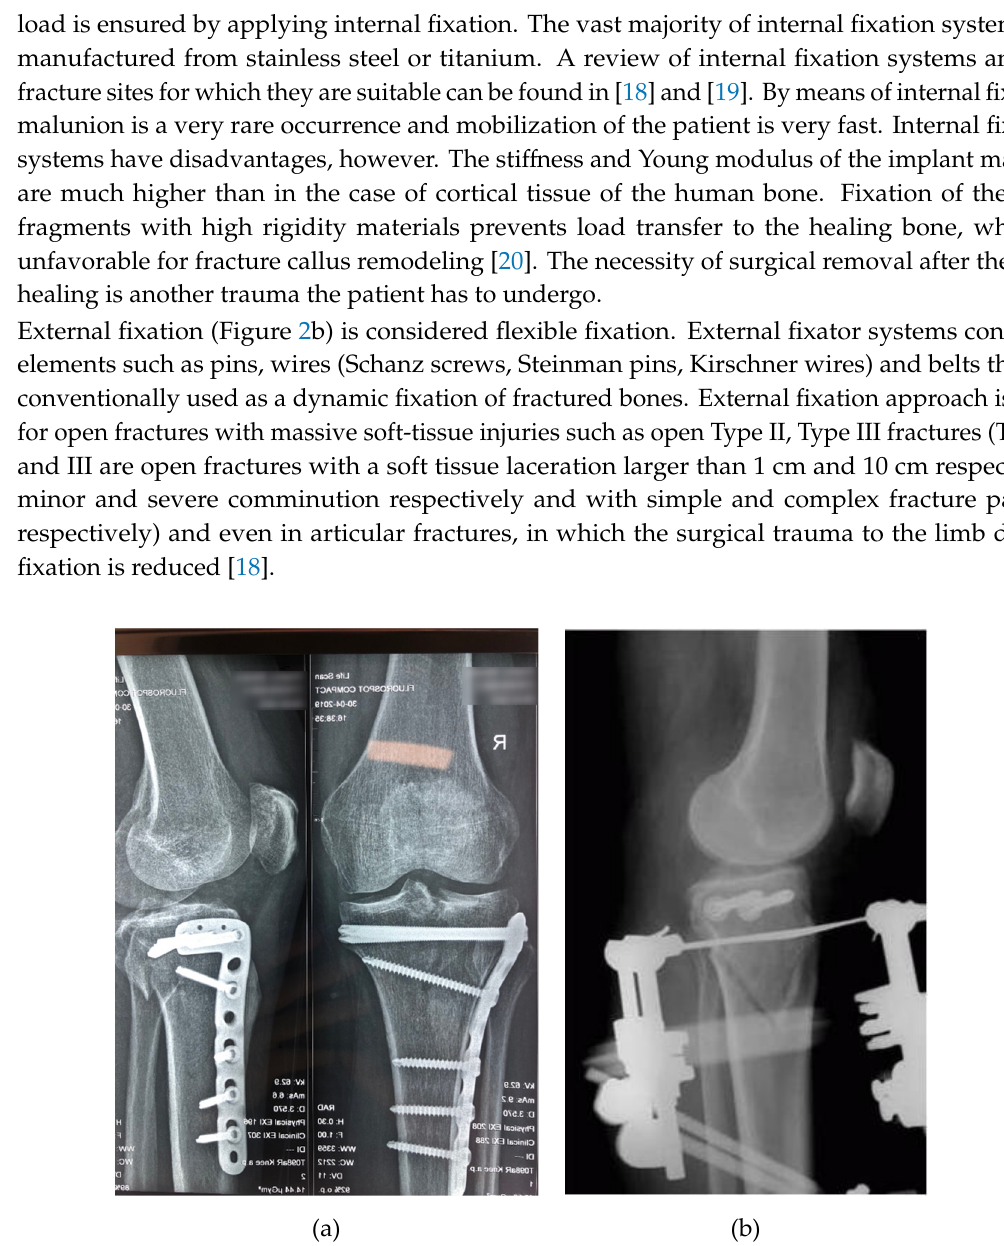
Figure 2. Internal fixators ( a ) and hybrid external fixator ( b ) used for fixation of tibial plateau fracture.